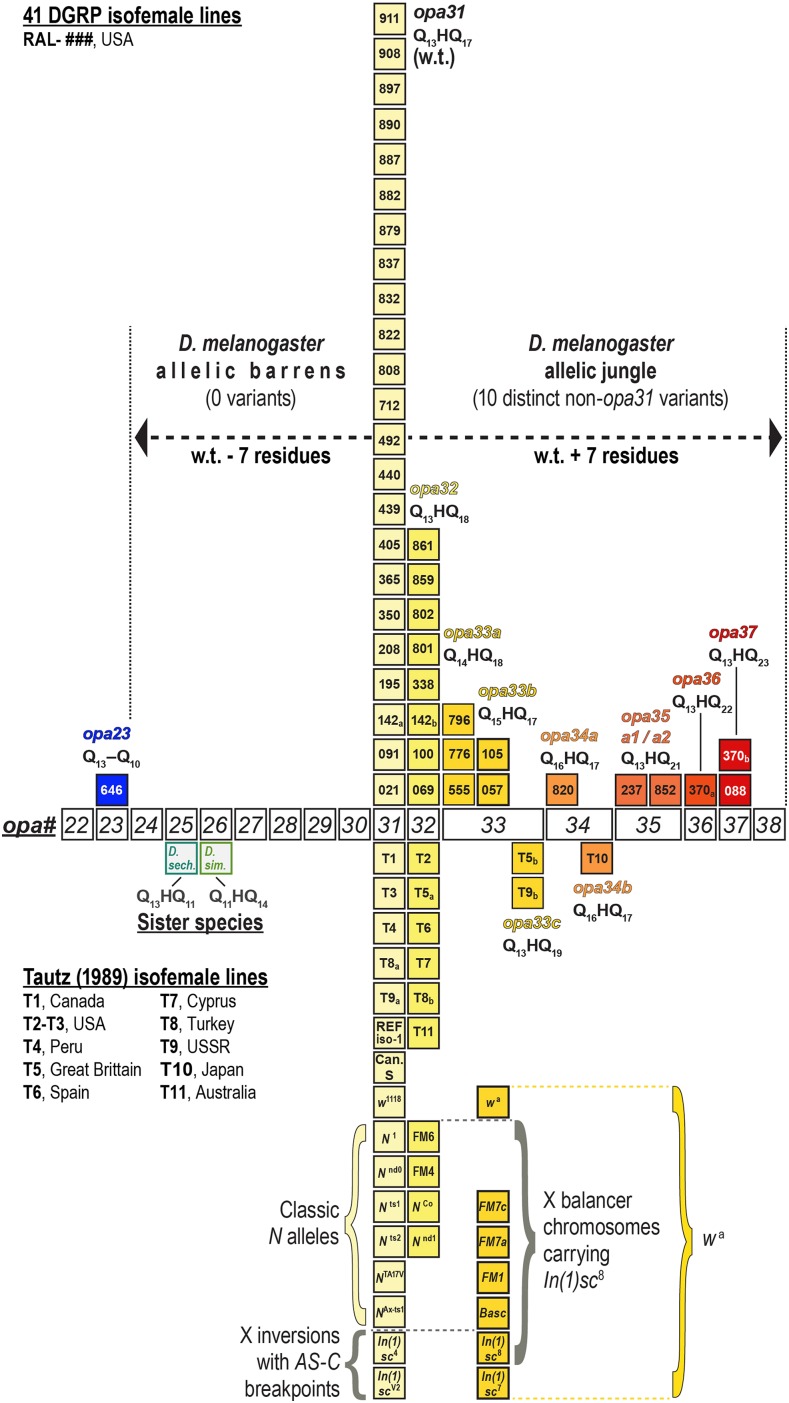
Shown is the distribution of opa-encoded pQ tracts of 41 RAL lines (boxes above line) genotyped by Sanger sequencing of multiple independent clones. Variants are shown from short (left, bluer boxes) to long (right, redder boxes), with each column representing a distinct opa allele. Heterozygous haplotypes (142a/142b and 370a/370b) are each represented by separate boxes. The distribution of opa alleles from D. melanogaster is highly asymmetric and does not harbor any alleles encoding <31 residues except for opa23, which is much shorter and missing the His codon. Because of this asymmetry, we refer to the range opa24–opa30 as the D. melanogaster allelic barrens, and to the range opa32–opa38 as the allelic jungle. Shown below the opa-# axis are several classic Notch alleles, X balancers, and X inversions, which we also genotyped (see text). Canton-S wild-type and NCo and Nnd1 mutant alleles have been previously reported (Kidd et al. 1986; Lyman and Young 1993). Also shown is the distribution of opa genotypes for 11 isofemale lines from different worldwide populations (Tautz 1989).